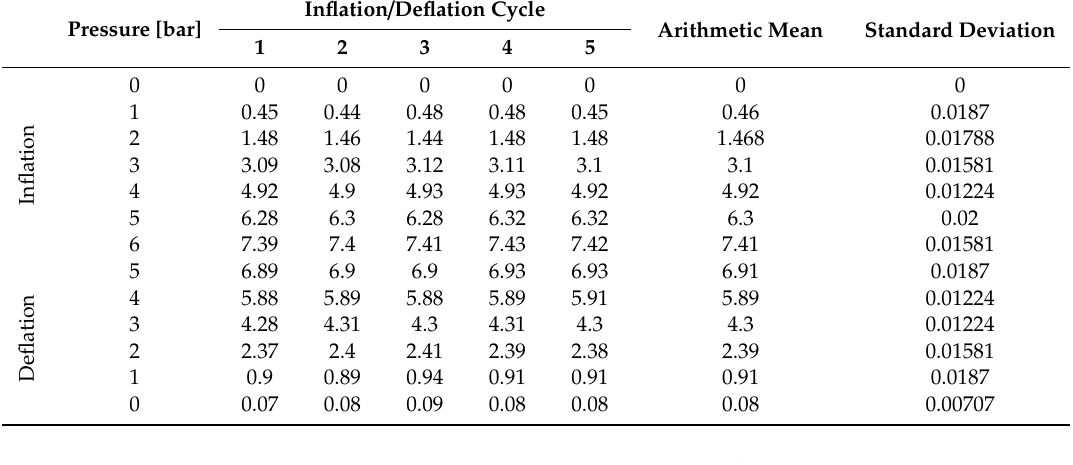
Table 3. Axial contraction of the pneumatic muscle for zero external load.